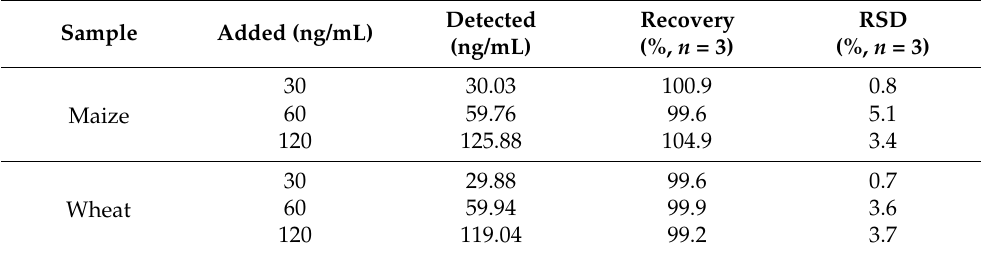
Table 2. Recovery and relative standard deviations of spiked maize and wheat samples with various ZEN concentrations of three